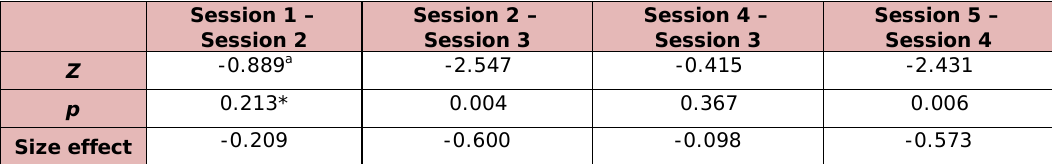
Table 2. “Pairwise comparison of LF oscillation change between subsequent sessions in real Operators”. Source: Own contribution.